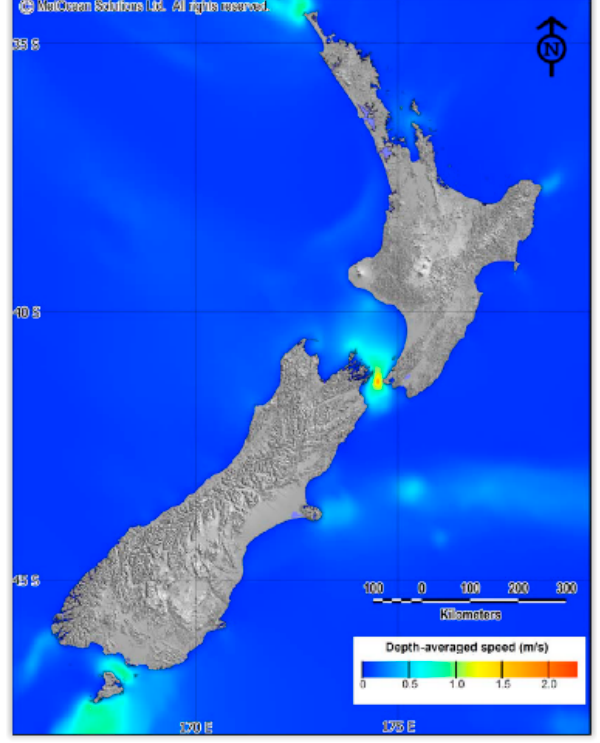
Figure 3. National depth-averaged tidal current speeds for mean spring flows (in m/s) [42].